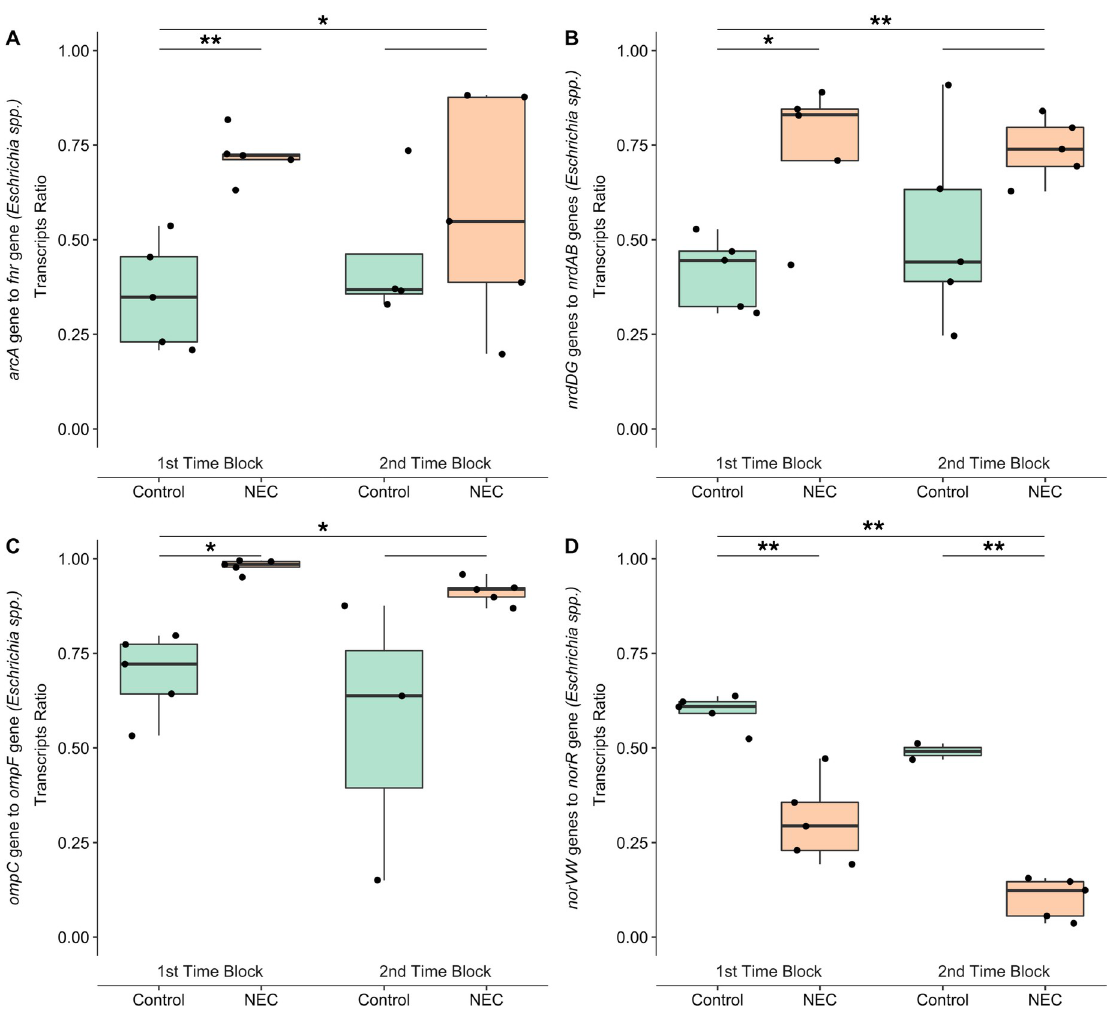
Fig 2. Transcriptional response to oxygen, Nitric oxide and osmotic conditions by Escherichia spp. in the gut of NEC and control premature infants. (A) Diametric ratios were compared between NEC and control infants in each time block (short lines above) and across all time points (longer lines). Distributions of diametric ratios were compared using Welch’s t-test with Bonferroni correction. Asterisks and double asterisks ( � , �� ) represent p < 0.05 and p < 0.01, respectively.(A) Diametric ratios of arcA and fnr transcript abundances of RNA reads mapped to sequences of Escherichia spp. genomes found in infants’ gut. (B) Diametric ratios of nrdDG and nrdAB transcript abundances of RNA reads mapped to sequences of Escherichia spp. genomes found in infants’ gut. (C) Diametric ratios of ompC and ompF transcript abundances of RNA reads mapped to gene sequences of Escherichia spp. genomes found in infants’ gut. (D) Diametric ratios of norVW and norV transcript abundances of RNA reads mapped to gene sequences of Escherichia spp. genomes found in infants’ gut.